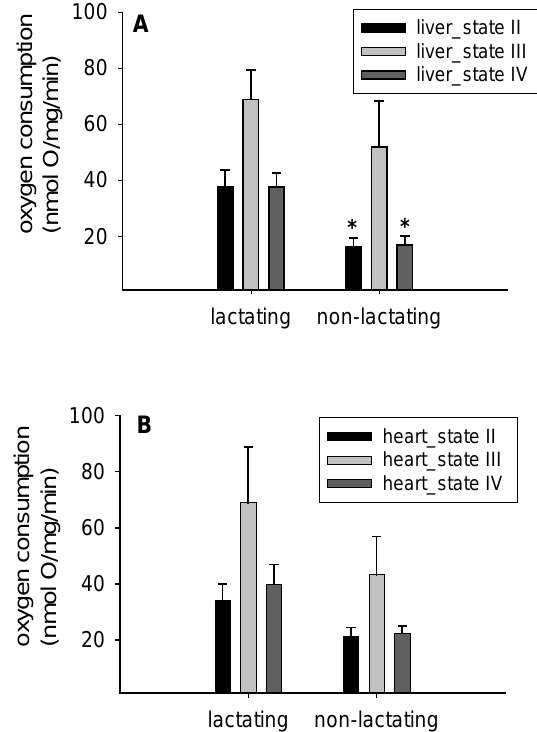
Figure 1. Oxygen consumption rates of isolated liver mitochondria ( A ) and isolated heart mitochondria ( B ) from lactating ( n = 12) and control mice ( n = 10). Data are means ± SEM; * p < 0.05 compared to lactating mice. Table 1. Respiratory control ratios (State III/State IV) and protein concentrations of isolated liver and heart mitochondria from lactating and non-lactating C57BL/6NCrl mice. Data are means ± SEM.